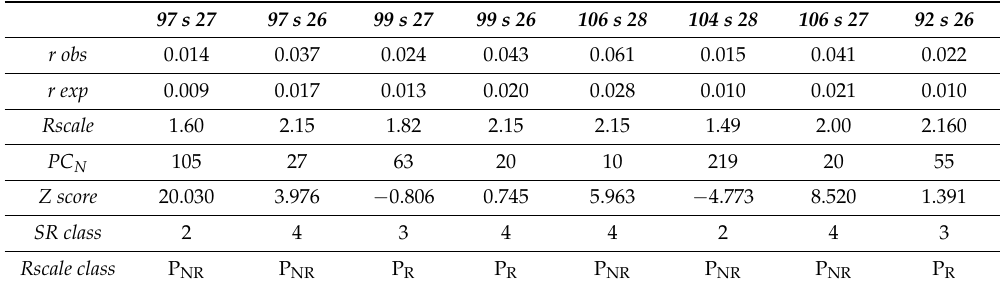
Table 4. Results of surface and regularity tests for the chosen targets.